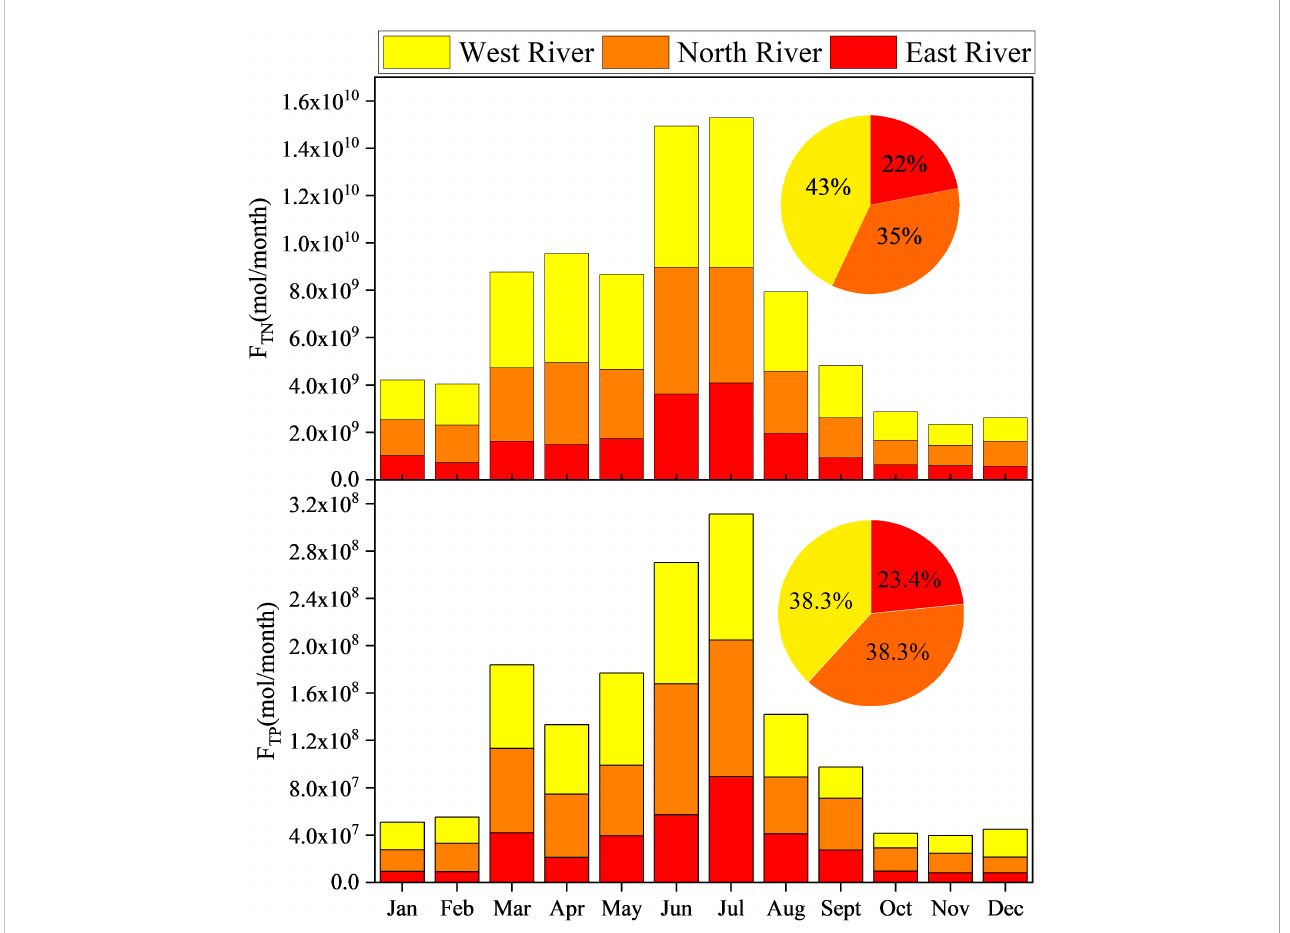
FIGURE 3 Spatiotemporal fl uxes and contribution patterns of TN and TP into major rivers (East, North, and West rivers) of the